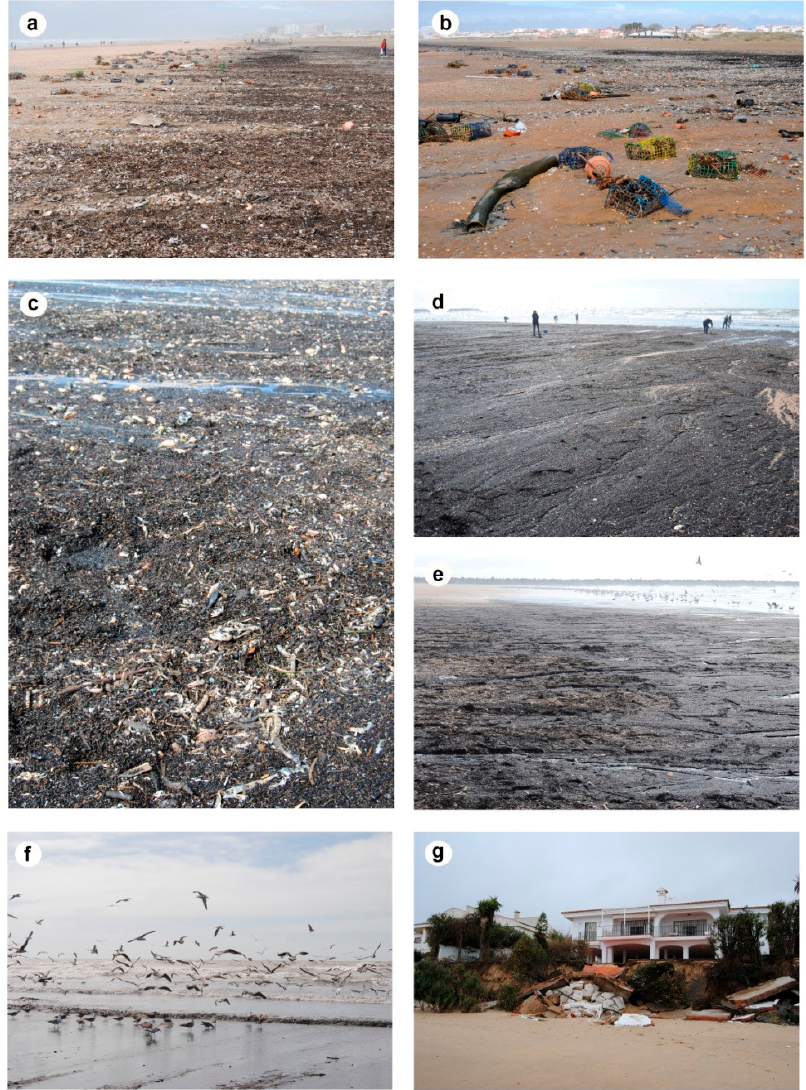
Figure 2. General view of the mass stranding at Punta Umbría beach, showing the stranding of marine organisms ( a – e ), nets and anthropogenic wastes ( b ). Collection of some stranded taxa by local fishers ( d ) and predation by waterbirds ( e , f ). Effects of storm Emma on beach erosion, close to the mouth of the Piedras river ( g ).